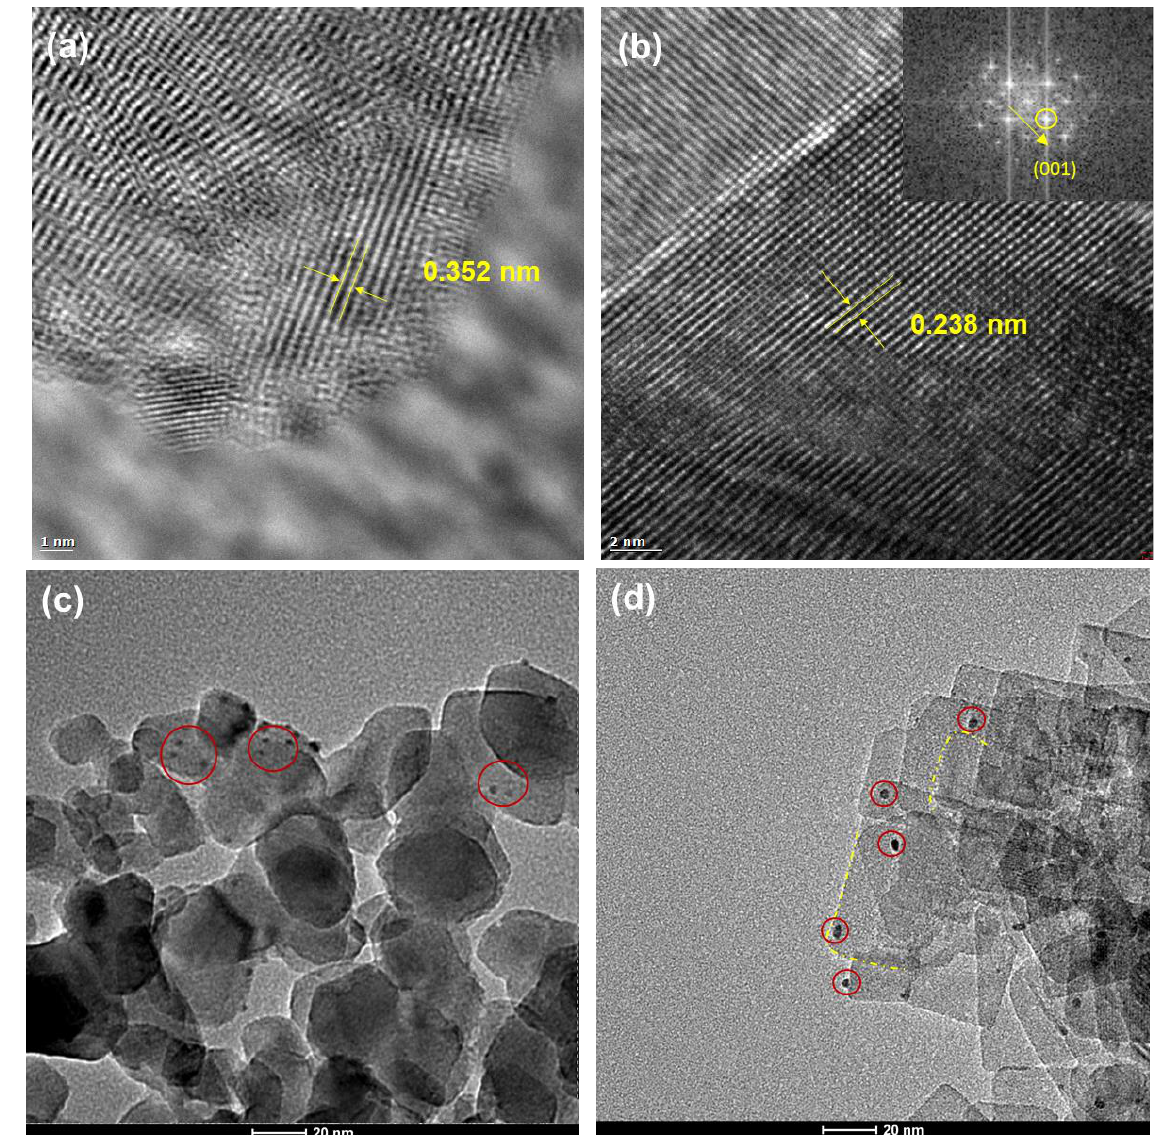
Figure 1. Magnified HR-TEM images obtained from ( a ) TiO 2 and ( b ) facet-engineered TiO 2 . The inset of ( b ) shows the FFT (Fast Fourier Transform) pattern of facet-engineered TiO 2 . HR-TEM images obtained from ( c ) Pt/TiO 2 and ( d ) Pt/facet-engineered TiO 2 . The concentration of Pt of each photocatalyst was fixed at 1.0 wt% with respect to TiO 2 on a weight basis. Red circles represent Pt nanoparticles loaded onto TiO 2 . Yellow lines represent the edge of facet-engineered TiO 2 .